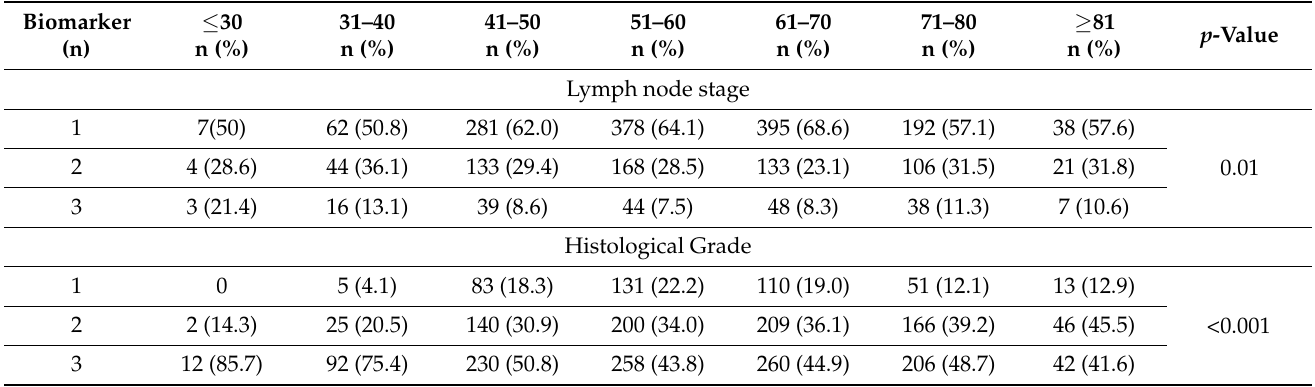
Table 1. Age standardised pattern of biological markers in early operable primary breast cancer.